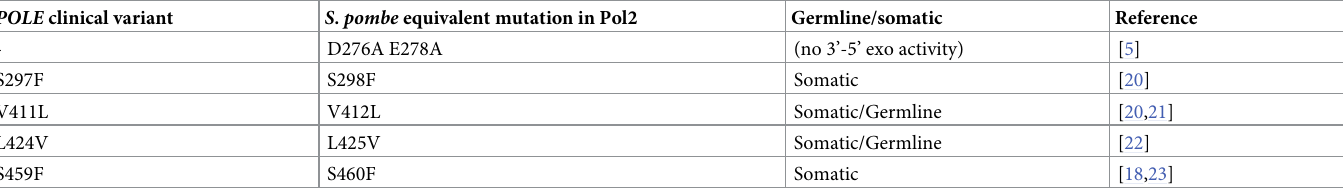
Table 1. DNA polymerase ε variants analysed in Fig